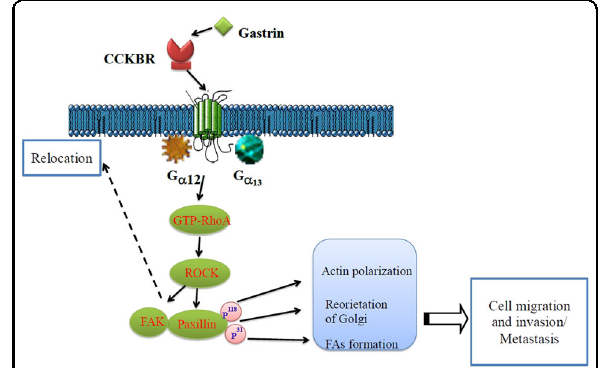
Fig. 7 Schematic model depicting the role of gastrin-CCKBR – G α 12/ 13 – RhoA – ROCK signaling in pancreatic cancer